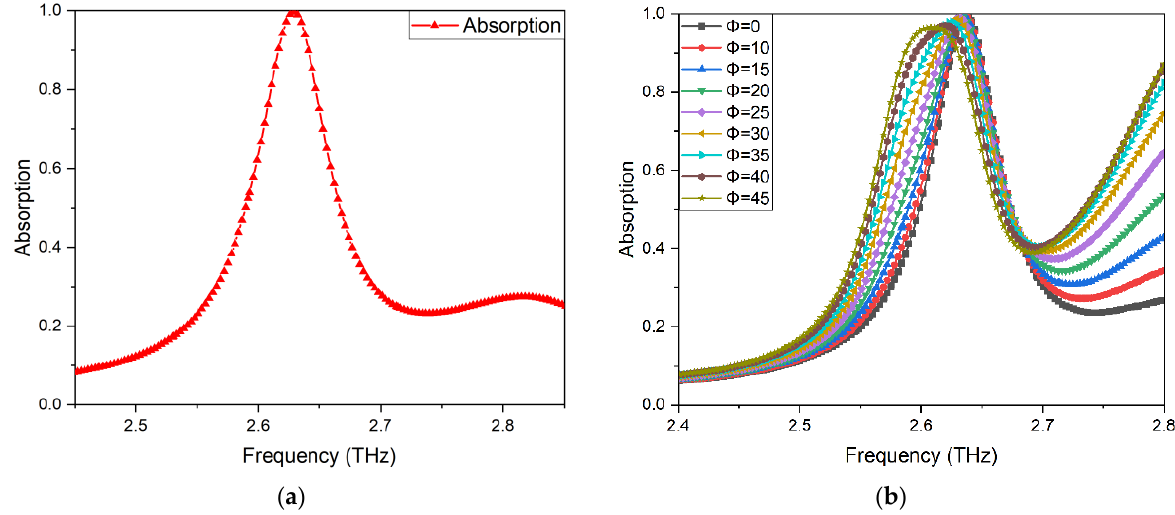
Figure 2. The absorption spectrum of the proposed TMA ( a ) for 0° polarization; ( b ) for other polarization angles.